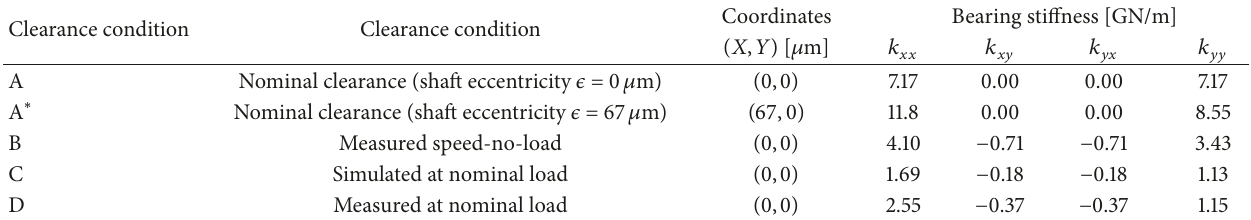
Table 5: Upper journal bearing direct and cross-coupled stiffness, for several clearances conditions, with viscosity 𝜂 = 0.035 Pas. Clearance condition